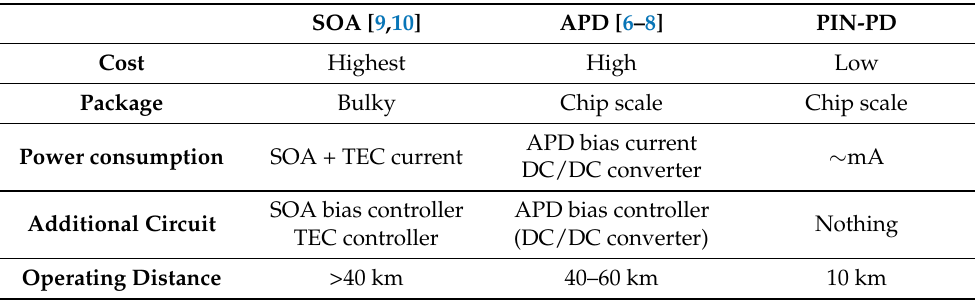
Table 1. The long-reach transmission technology of an optical transceiver. SOA